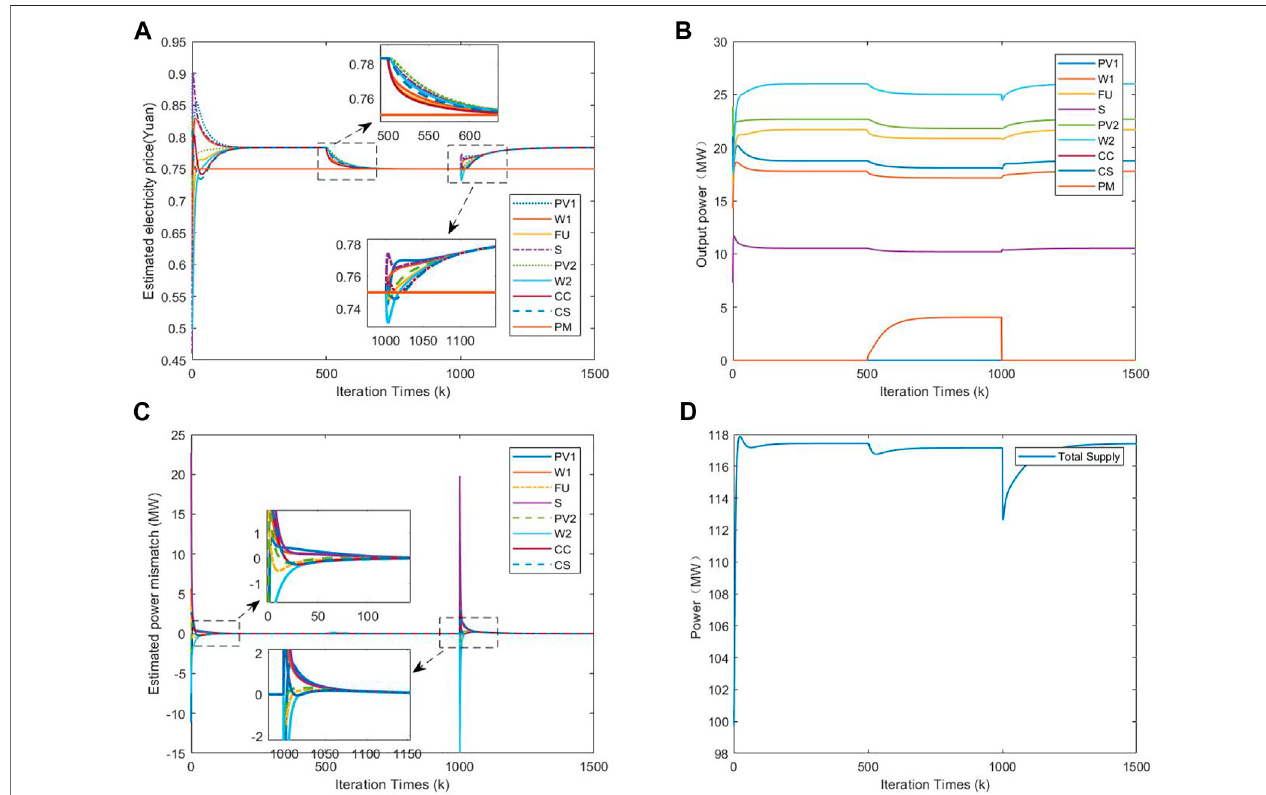
FIGURE9| Simulationresultsof “ island-grid-island ” switchingmode. (A) isthedynamiccurveoftheelectricityprice λ , (B) isthedynamiccurveofthepoweroutput, (C) is the dynamic curve of the estimated power, (D) is the dynamic curve of the total supply.